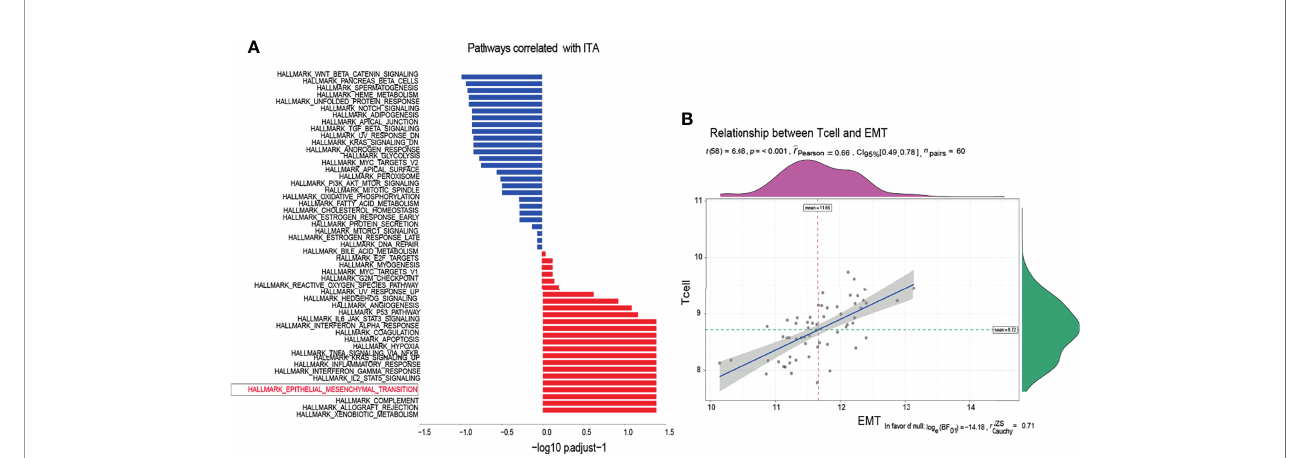
FIGURE 2 | Enrichment of T-cell in fi ltration-related pathways. (A) According to the enrichment of characteristic molecules, the pathways closely related to T-cell in fi ltration were obtained. (B) The expression level of EMT characteristic molecules was positively correlated with that of T